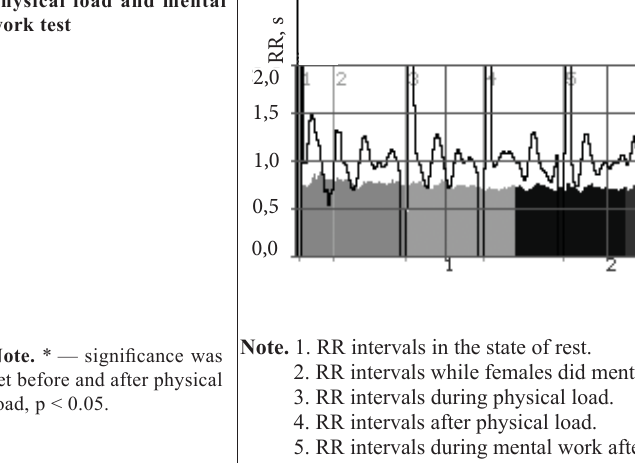
Fig. 1. RR intervals during physical load and mental work